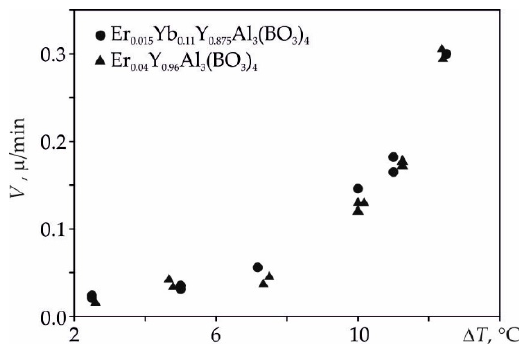
Figure 8. Normal growth rate vs. relative supercooling for Er:YAB and (Er,Yb):YAB epitaxial layers from a 17–83 wt.% (88.1 wt% K 2 Mo 3 O 10 − 8.6 wt% B 2 O 3 − 3.3 wt% Y 2 O 3 ) solvent [35]. Reprinted from the Journal of Crystal Growth, 401, Volkova E., Maltsev V., Kolganova O., Leonyuk N.I., High-temperature growth and characterization of (Er,Yb):YAl 3 (BO 3 ) 4 and NdAl 3 (BO 3 ) 4 epitaxial layers, 547–549, Copyright (2014), with permission from Elsevier.